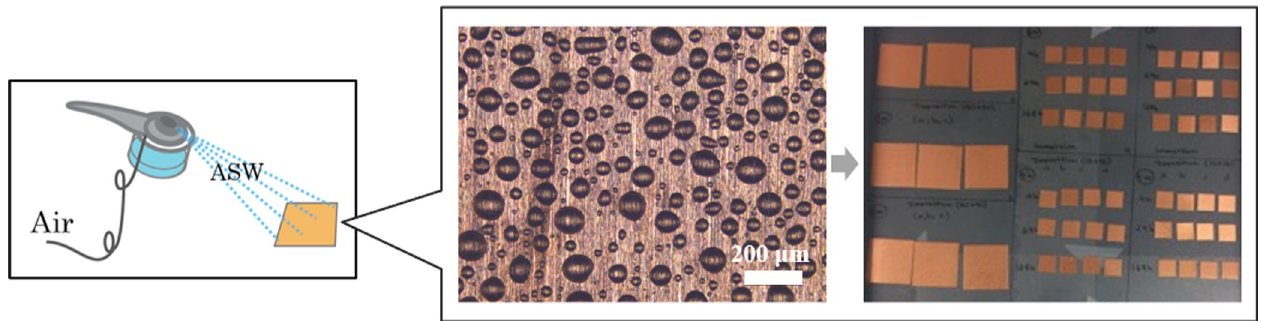
Fig 4. Illustration of deposited ASW droplets (scale bar 200 μ m) sprayed by means of an air-brush (left) onto several Cu coupons (middle) simultaneously for further exposure (right) to cyclic wet/dry exposure conditions in a climatic chamber for 1 day to 4 weeks.